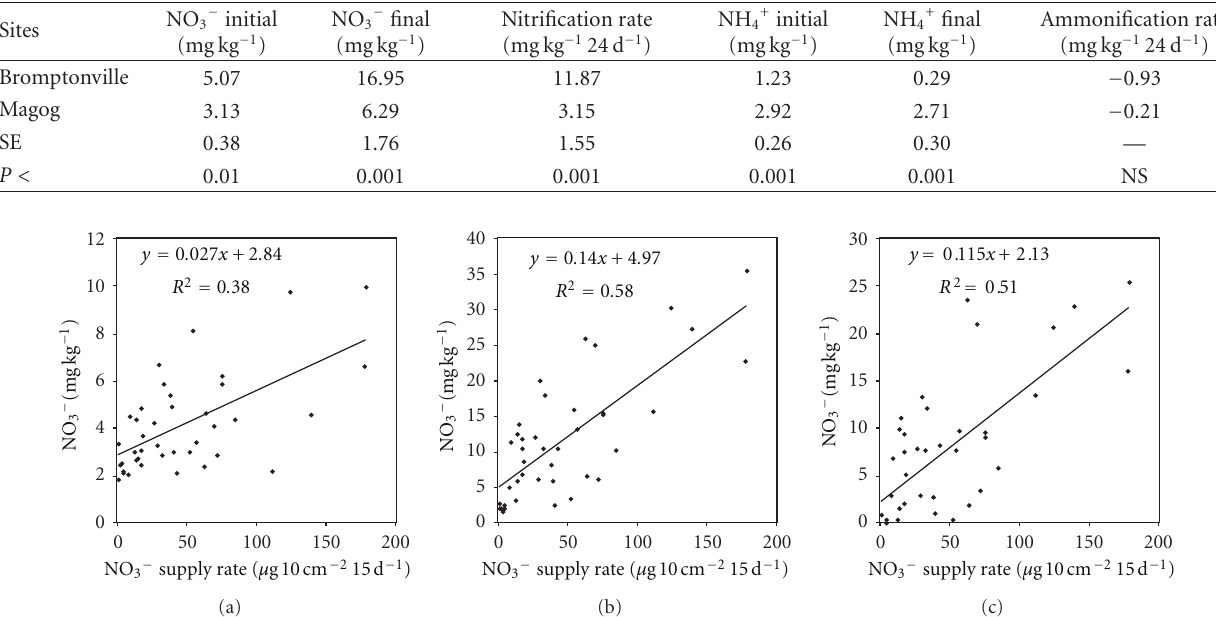
Table 3: Nitrification and ammonification rates measured during a 24 days period at the two riparian sites (July 17–August 9, 2007). Nitrate and ammonium concentrations at the beginning (initial) and at the end (final) of the in situ incubation period are also presented.